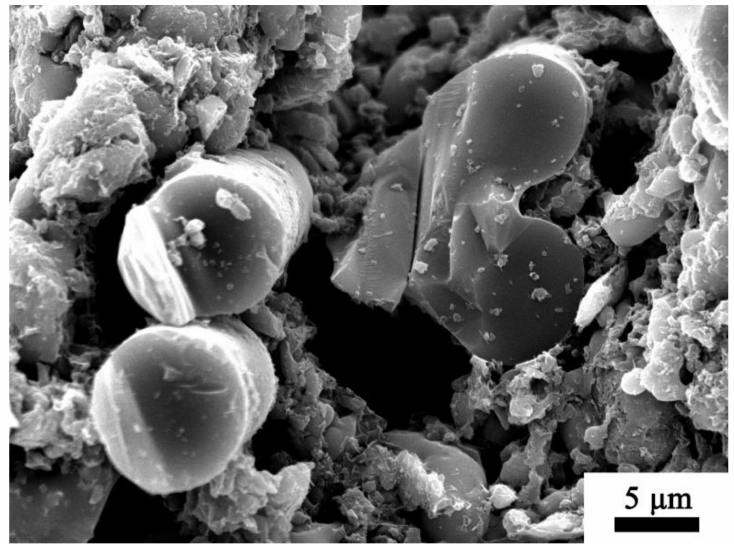
Figure 7. Micromorphology of sample R4 treated at 1200 ◦